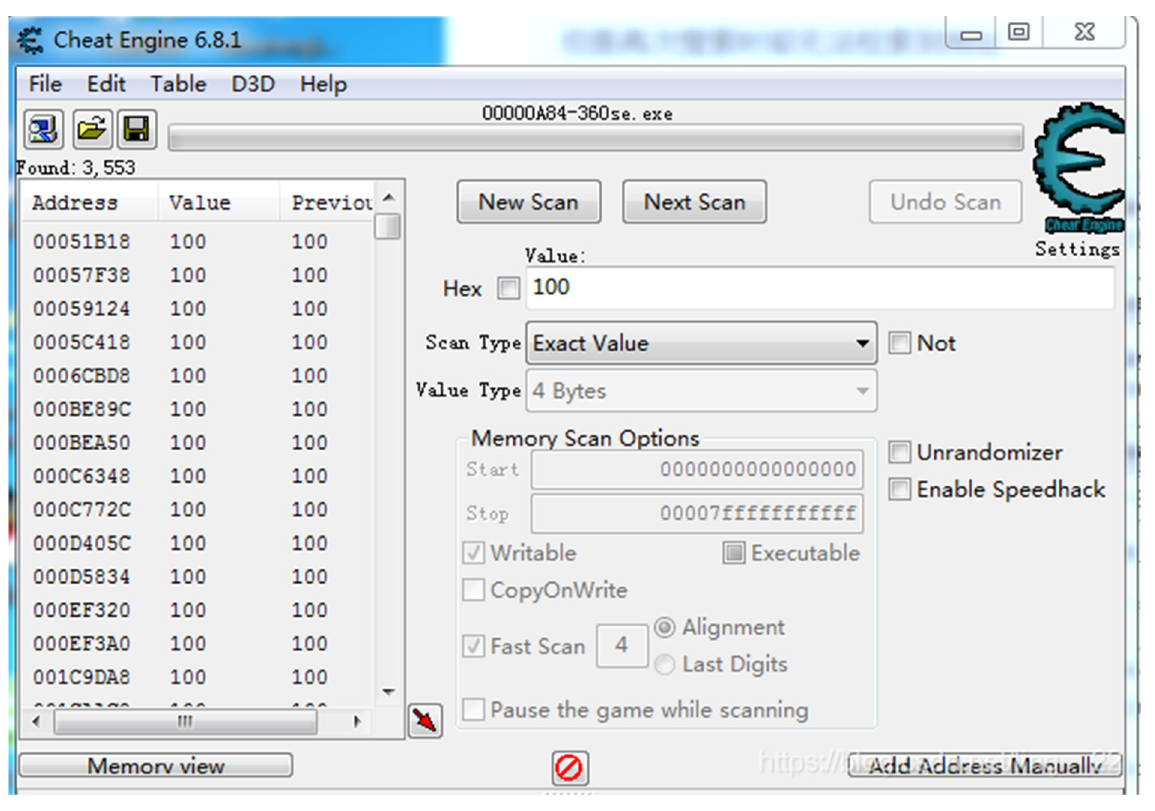
Figure 5. Cheat Engine.